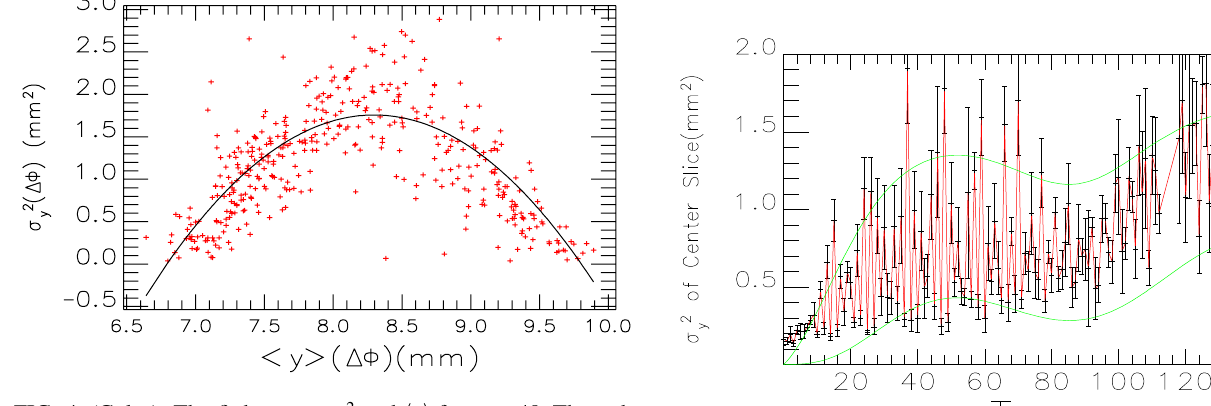
and h y i for turn 48. The red y / (cid:2) 0 : 775 h y i 2 . The FIG. 6. (Color) The (cid:7) 2 of the center slice changes with turn y y number.